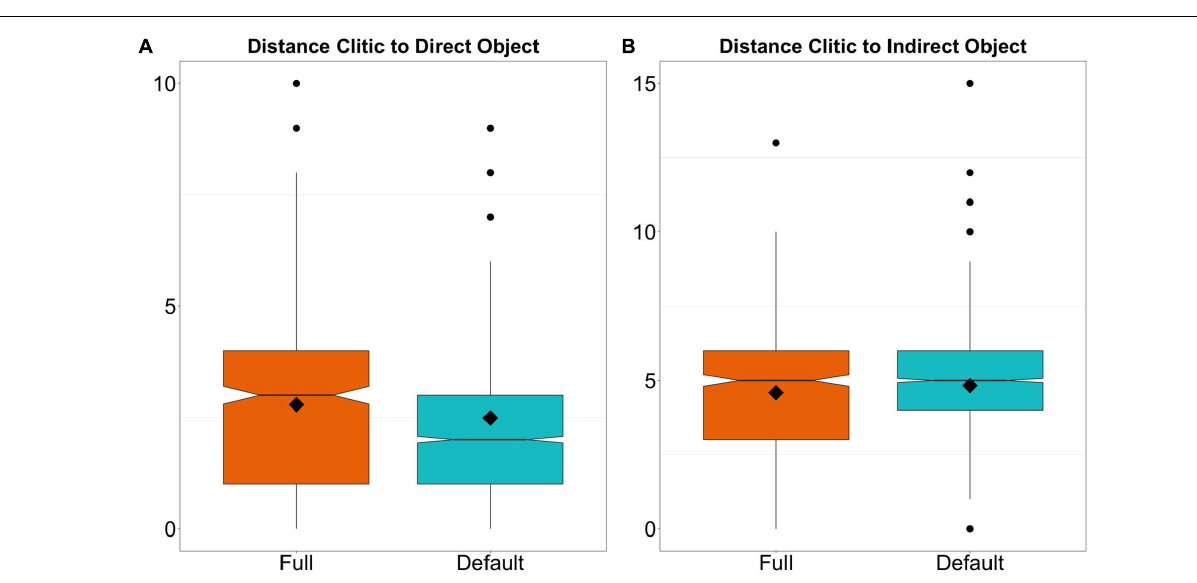
FIGURE 3 | Distribution of number of syllables between the clitic and the direct object (A) and the clitic and the indirect object (B) . The rhomboid shows the mean, the line the median and the black dots are